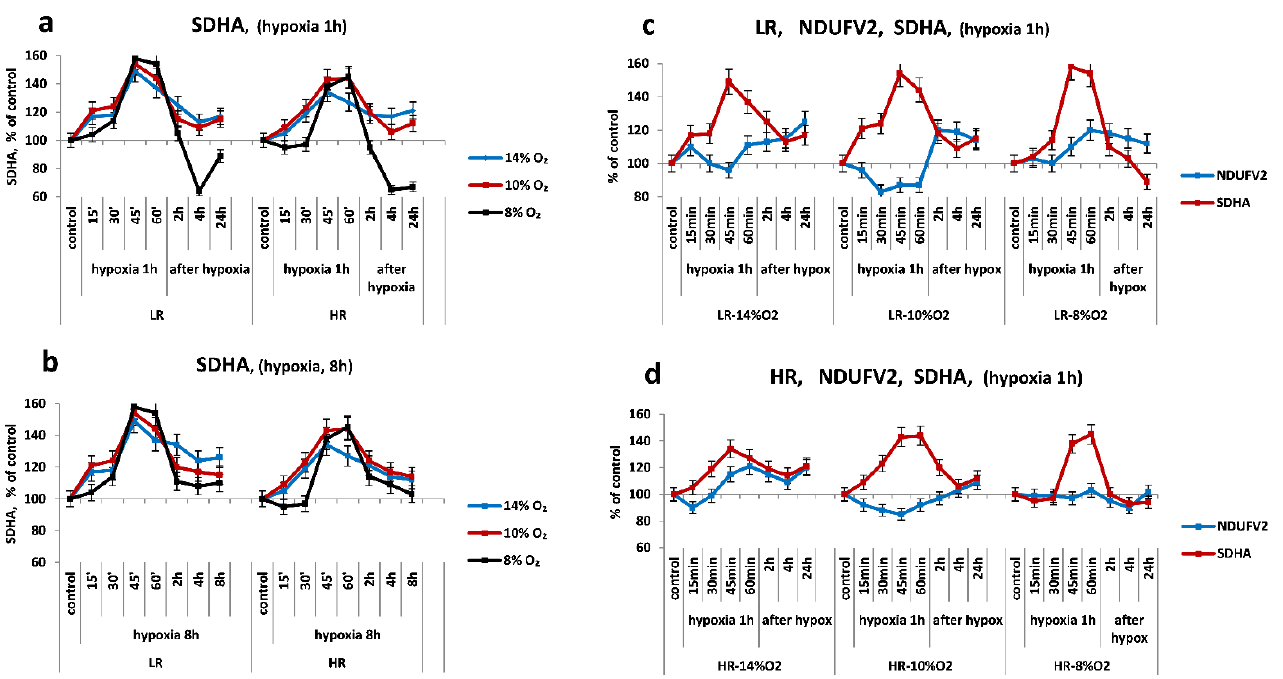
Figure 3. Dynamics of the expression of catalytic subunits of respiratory enzymes (NDUFV2, SDHA- MC I-MC II) in LR and HR rat myocardium during a single 1-h hypoxic exposure (min) and in the post-hypoxic period (2 h and 24 h). Leftward: Effect of 1-h ( a ), and 8-h ( b ) hypoxic exposure (FiO 2 – 14%, 10%, 8%) on the dynamics of SDHA expression in the myocardium of LR and HR rats. On the right: Effect of 1-h hypoxic exposure (FiO 2 – 14%, 10%, 8%) on the dynamics of SDHA and NDUFV2 expression in the myocardium of LR ( c ) and HR ( d ) rats. The ordinate axis shows Western blot analysis data in % of the control taken as 100%. Along the abscissa axis is the time of tissue sampling during hypoxia (minutes), and in the post-hypoxic period (hours). On the contrary, after 15 min of hypoxic exposure at FiO 2 = 10%, a sharp